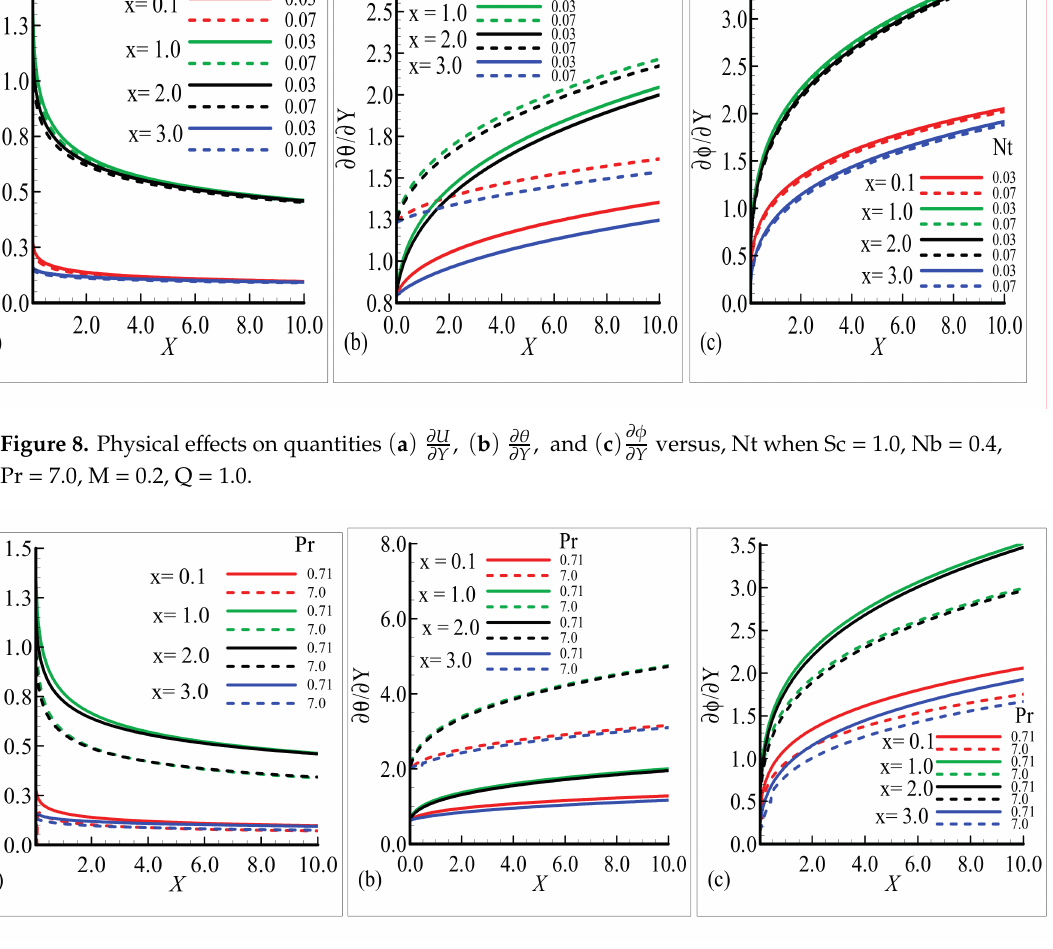
∂φ ∂θ ( c ) , ( b ) ∂ Y , and ∂ Y versus, Pr when Sc Y